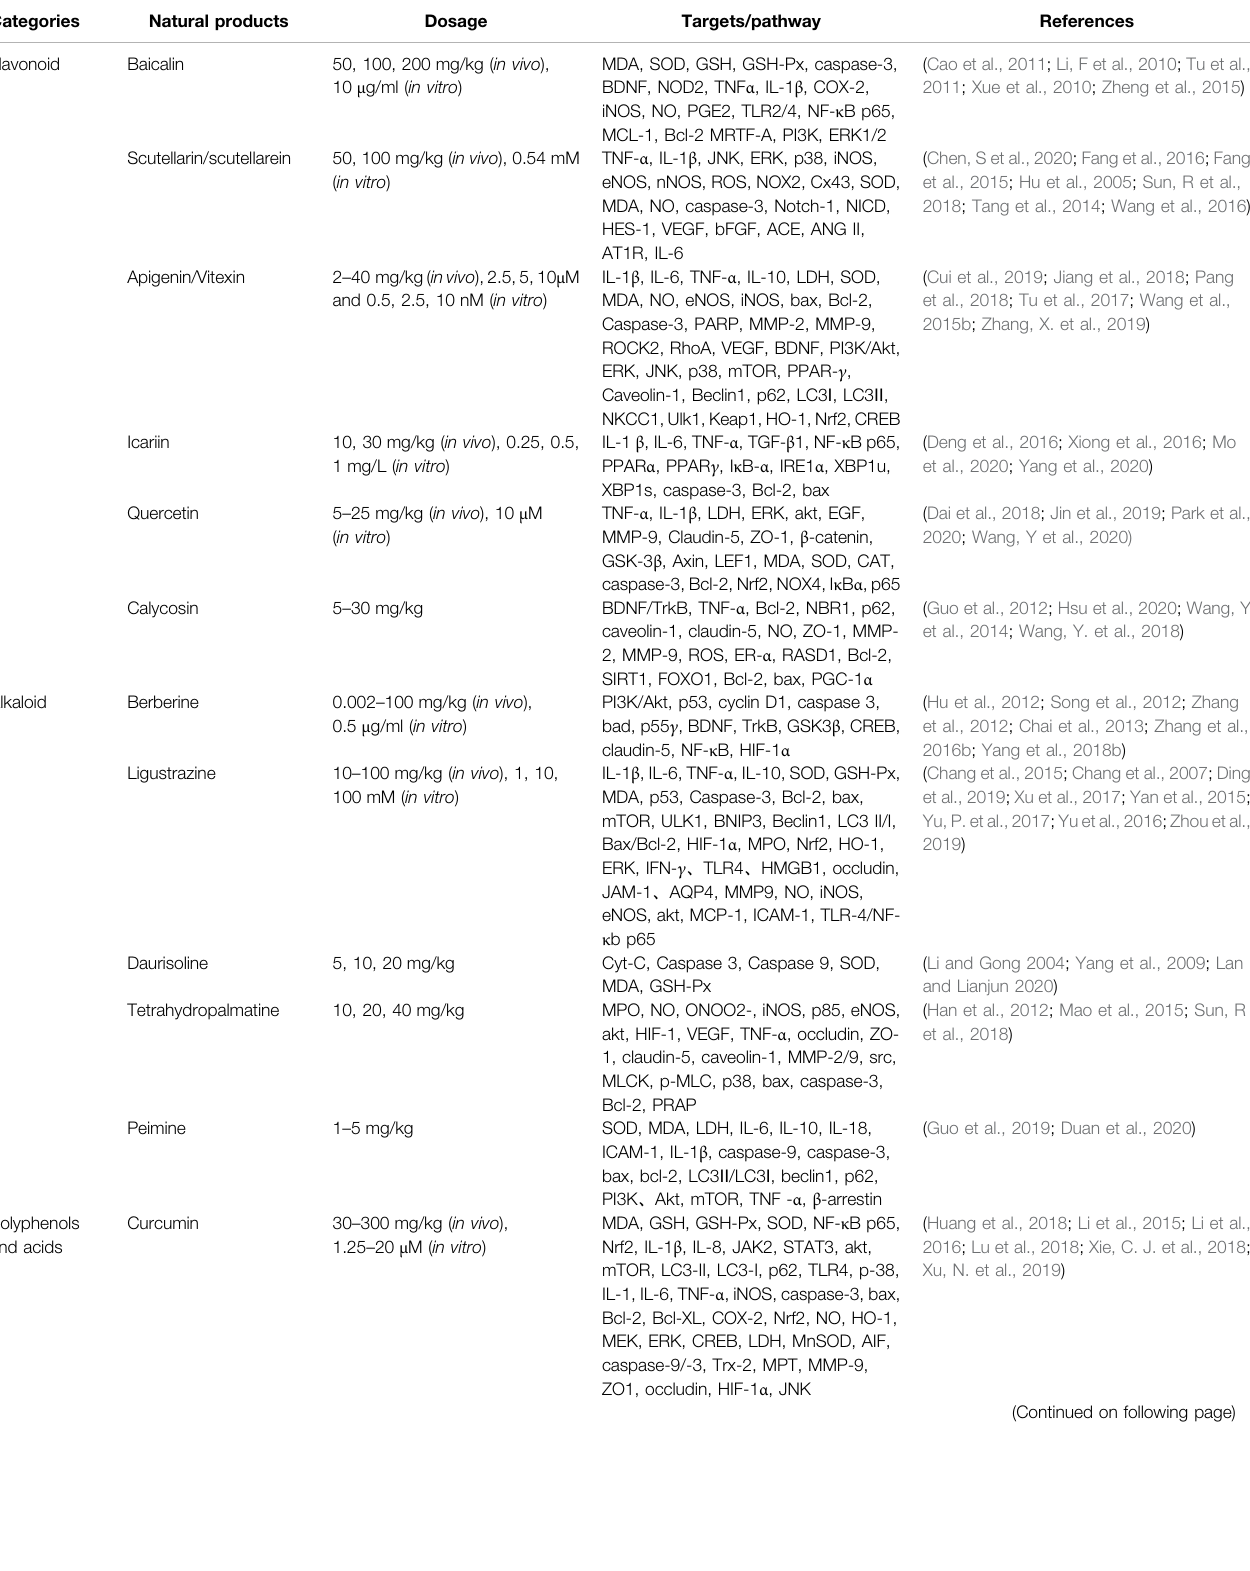
TABLE 1 | Summary a few natural products and their targets of action imparting neuroprotective